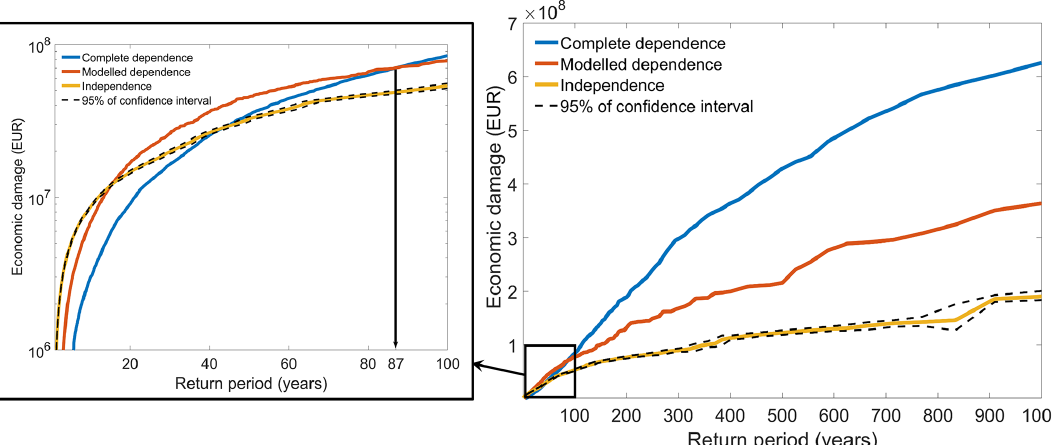
Figure 4. Risk curves for the Elbe catchment for three dependence assumptions (complete dependence, complete independence and modelled dependence). The left panel zooms in on the risk curves up to the 100-year return period of damage.